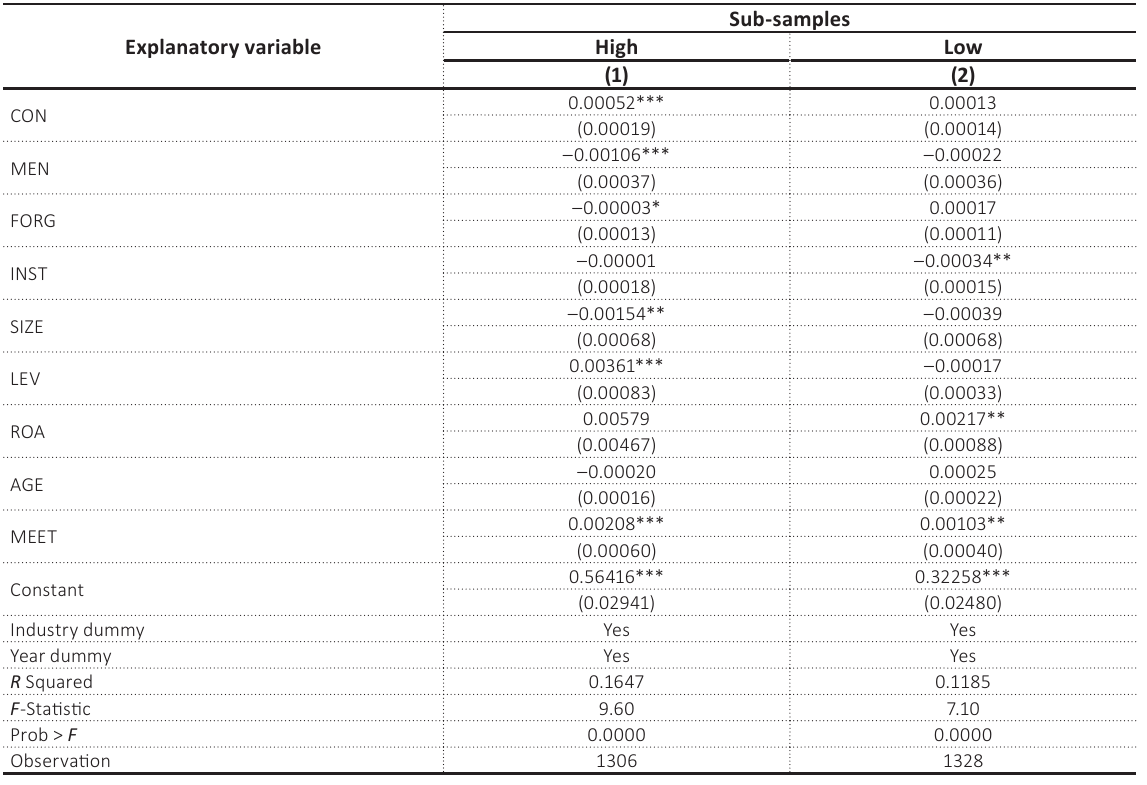
Table 6. Impact of ownership structure on intellectual capital disclosure: high vs